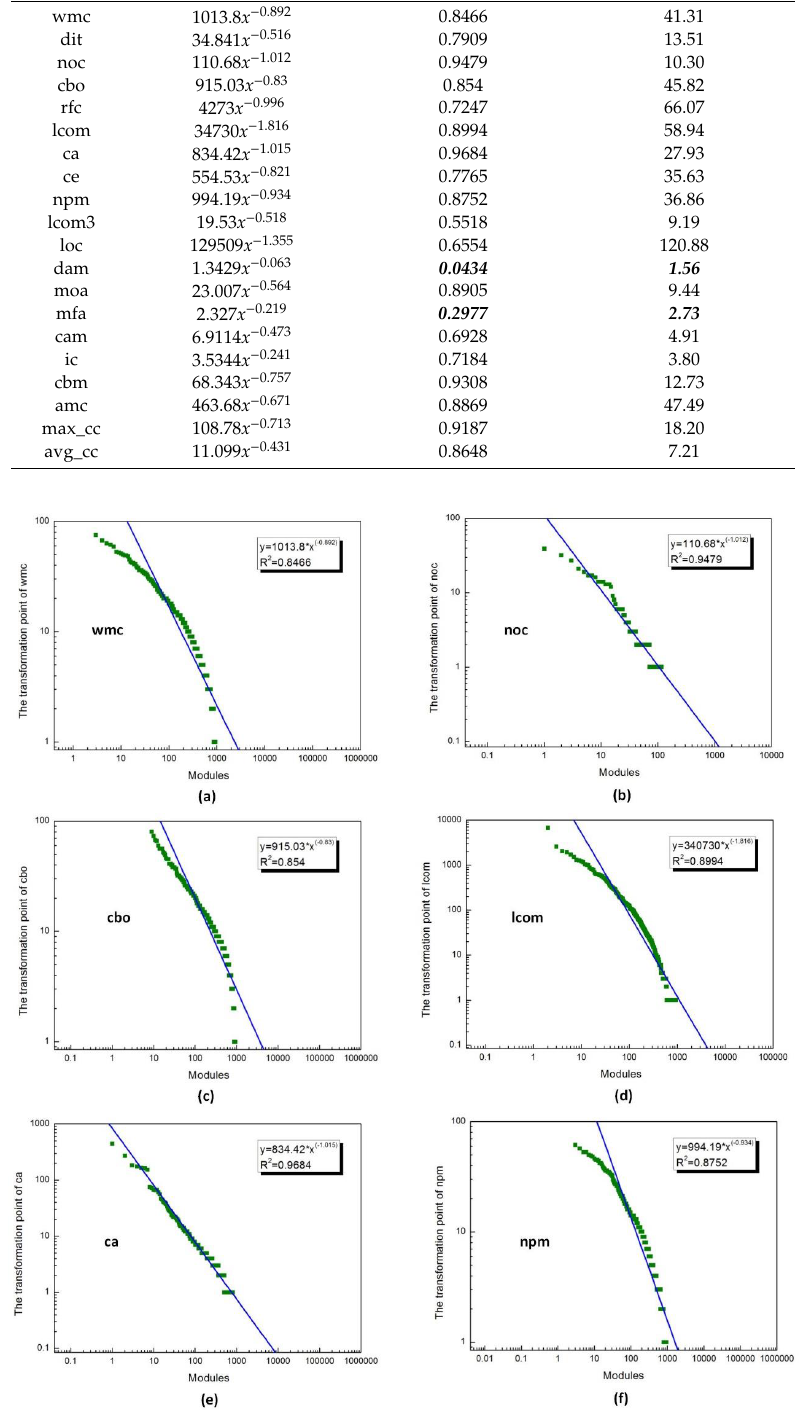
Figure 5. Power law functions with respect to different metrics. ( a ) wmc: weighted methods per class; ( b ) noc: number of children of a given class in an inheritance tree; ( c ) cbo: number of classes that are coupled to a given class; ( d ) lcom: number of method pairs in a class that do not share access to any class attributes; ( e ) ca: a ff erent coupling, which measures the number of classes that depend on a given class; ( f ) npm: number of public methods in a given